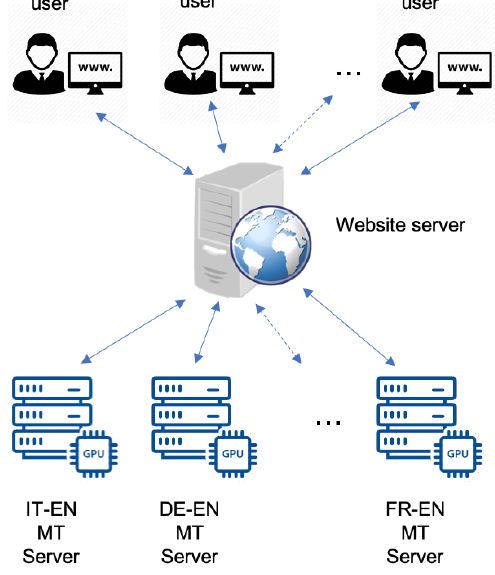
Figure 1. Architecture of the ADAPT COVID-19 Online MT System.